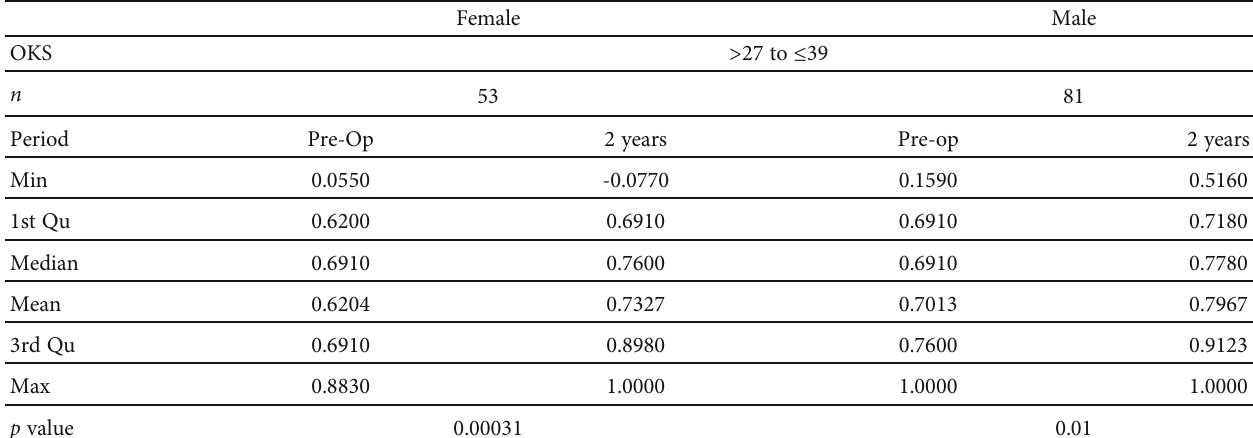
Table 3: EQ-5D score at preoperative baseline and at two years ’ follow-up for all patients with OKS > 27 to ≤ 39 at baseline. Female Male OKS > 27 to ≤ 39 53